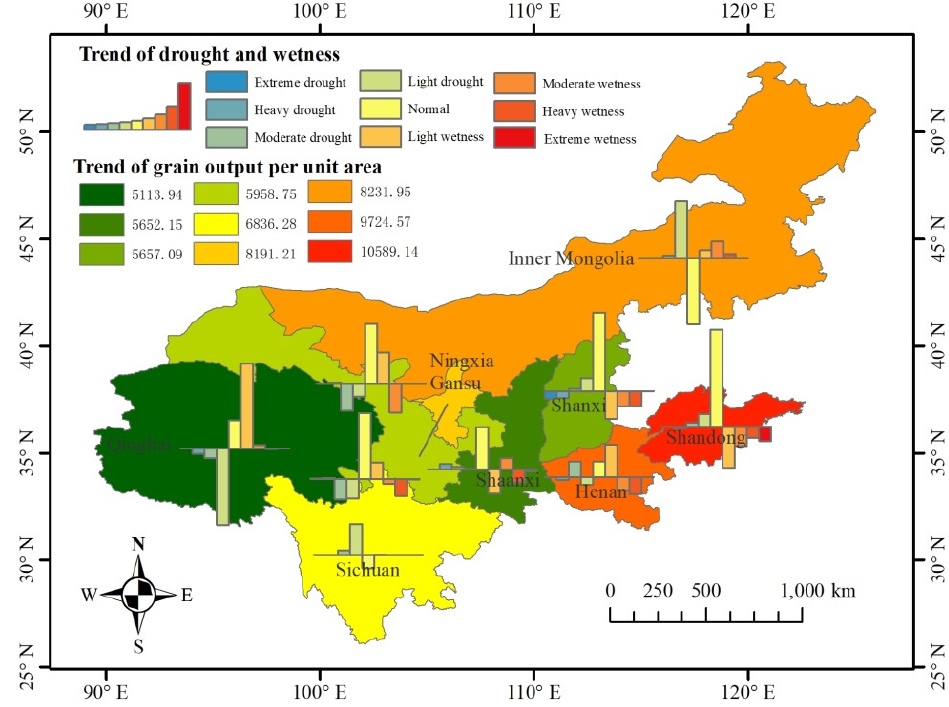
Figure 6. Spatial distribution of drought and wetness degree trends and grain yield per unit area trends in various provinces and regions of the Yellow River basin.